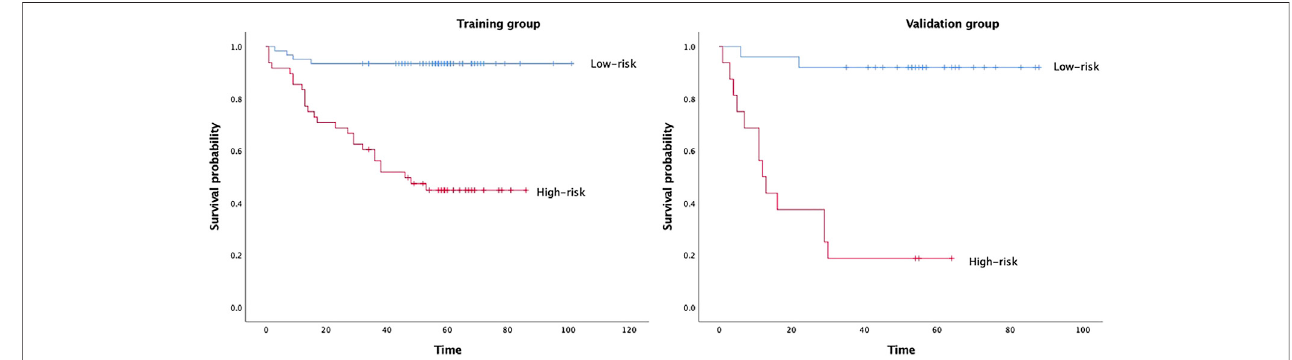
FIGURE 2 | Kaplan – Meier survival analyses according to the radiomics signature with low-risk and high-risk patients in training and validation groups.